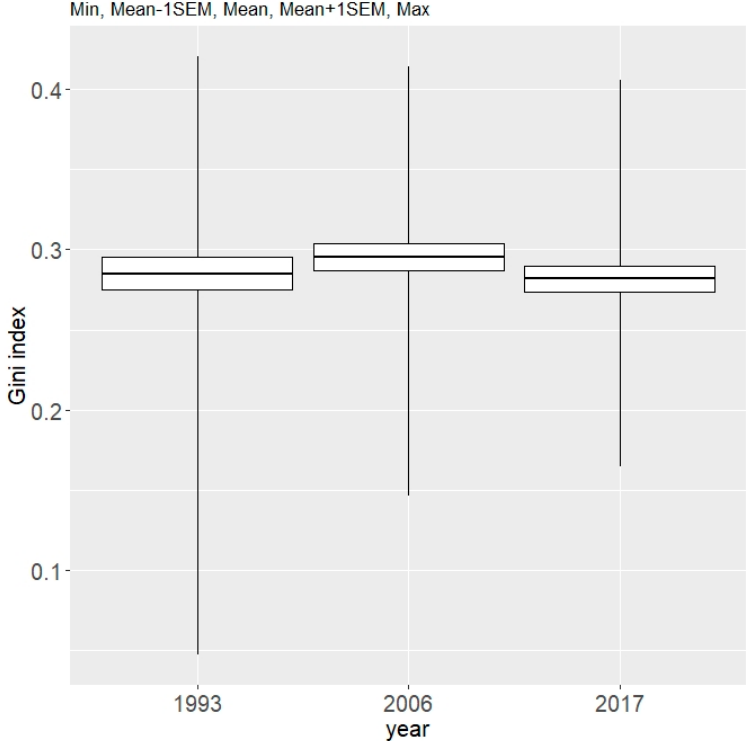
Figure 9. Mean values of Gini index (describing tree diameter inequality, regardless of tree species)